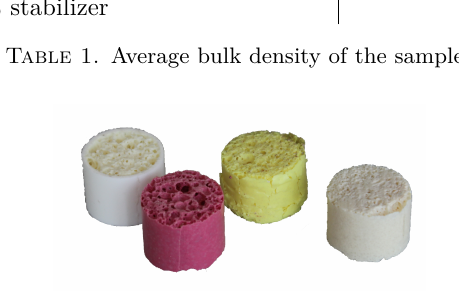
Figure 1. Four types of samples – color-coded according to the filler